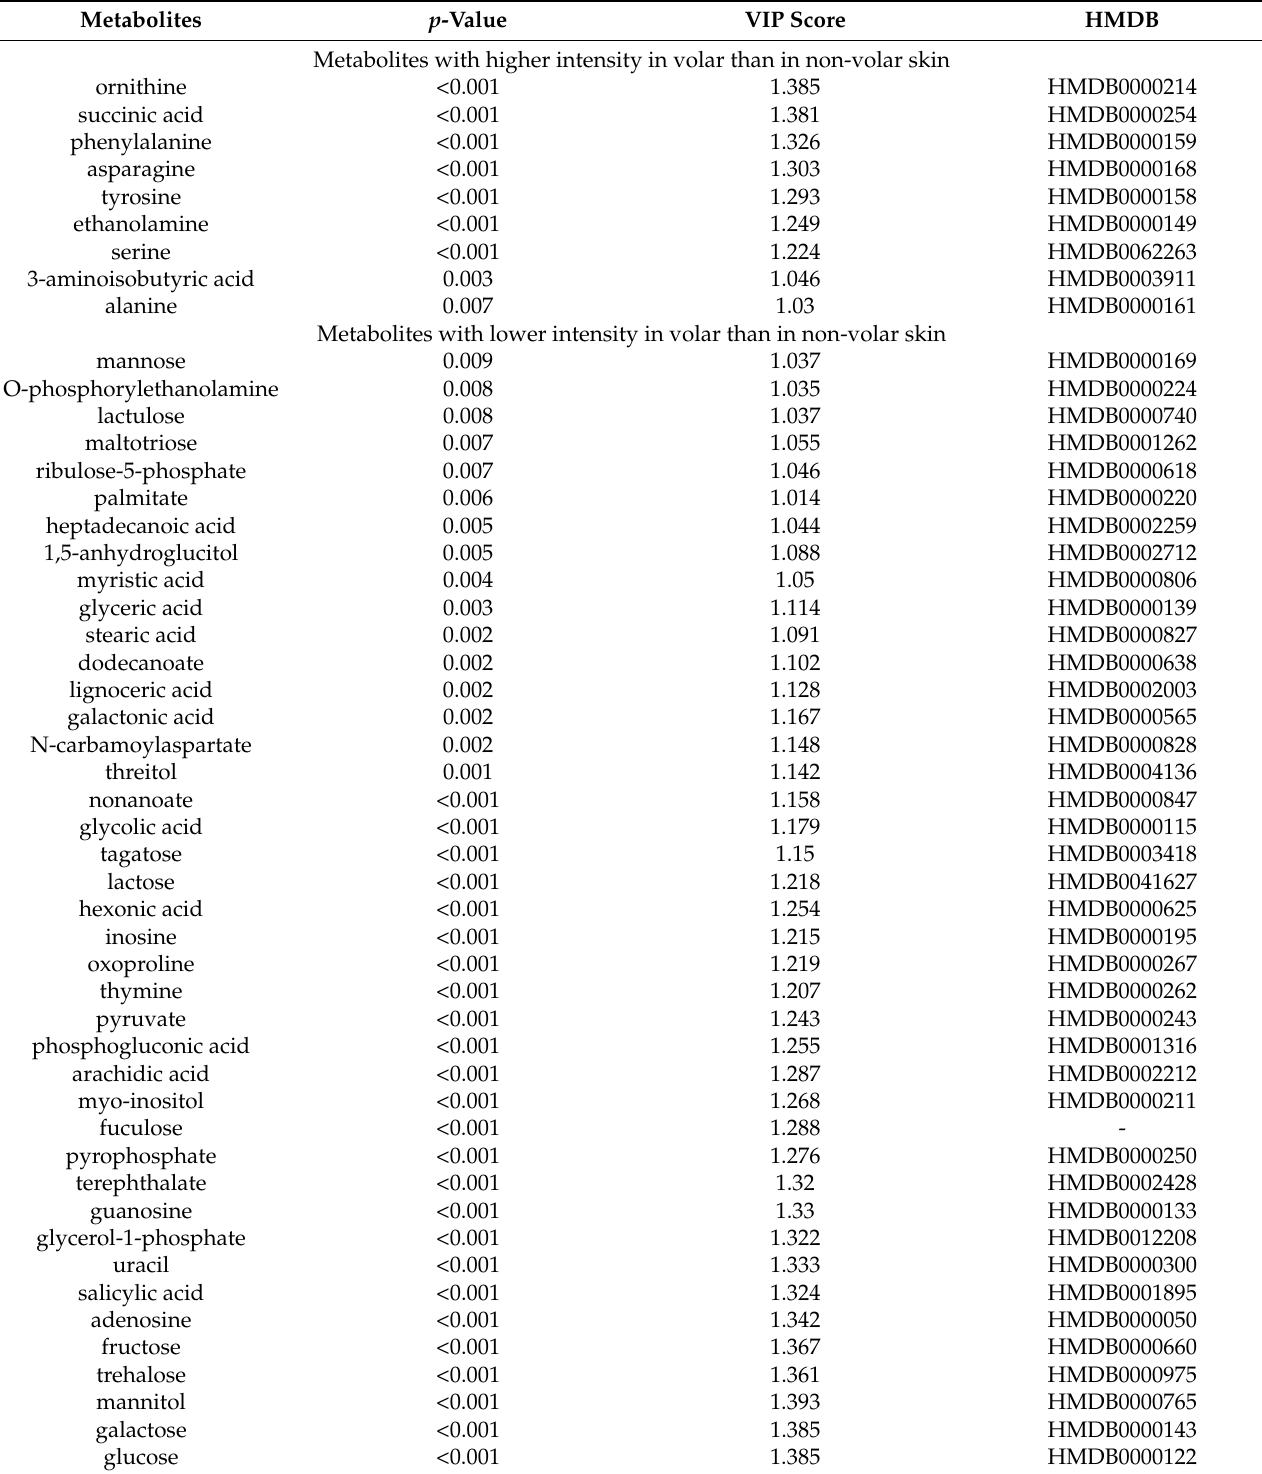
Table 3. Metabolites screened from volar skin and non-volar